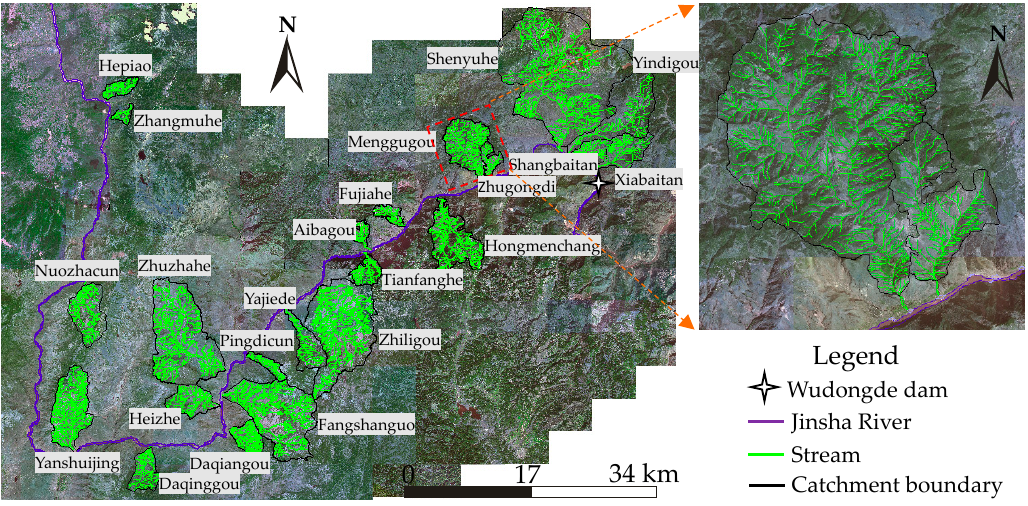
Figure 2. Location of the debris flow gullies.